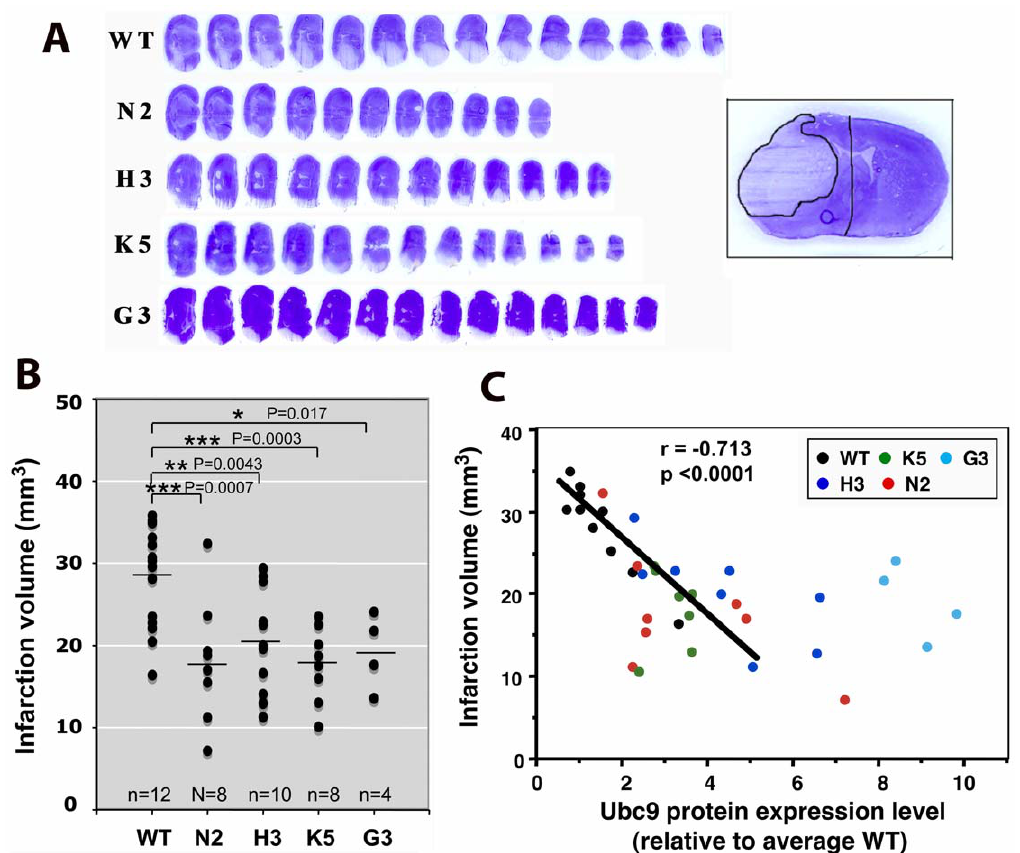
Figure 2. Ubc9 transgenic mice are more tolerant to ischemia than WT mice. (A) Examples of cresyl violet stained coronal brain sections from WT and Ubc9 transgenic mice (N2, H3, K5 and G3) after 24 h pMCAO. The inset shows an enlarged section with a clear infarcted area for a precise measurement. (B) Scatter plot of brain infarction volumes in WT (n=12) and Ubc9 transgenic mice, N2 (n=8), H3 (n=10), K5 (n=8) and G3 (n=4) after 24 h pMCAO. Average infarction volume in each animal group is shown as a short horizontal line. *P , 0.05, **P , 0.01, ***P , 0.001. (C) The brain infarction volumes (y-axis) after 24 h pMCAO are plotted against their Ubc9 protein levels (x-axis). A correlation is seen among animals whose Ubc9 levels are under 5-fold of wild type. (Pearson correlation coefficient) r= 2 0.713, p ,